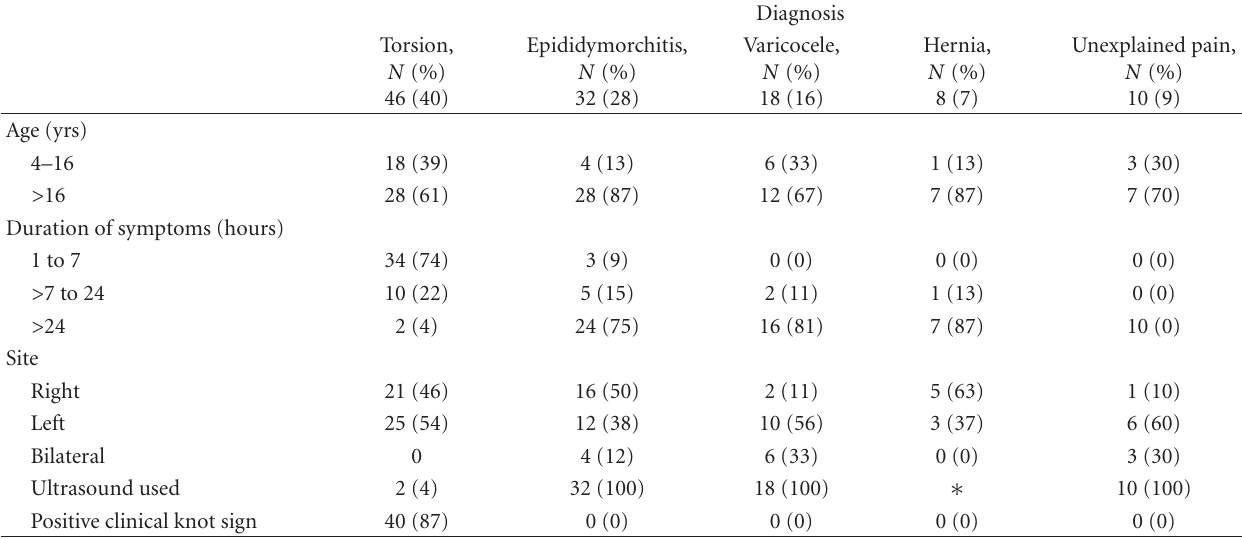
Table 1: Descriptive statistics of patients stratified by